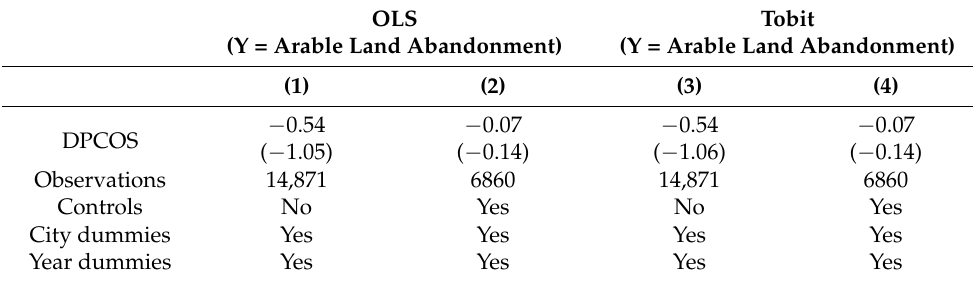
Table 3. Baseline results: The impact of DPCOS on arable land